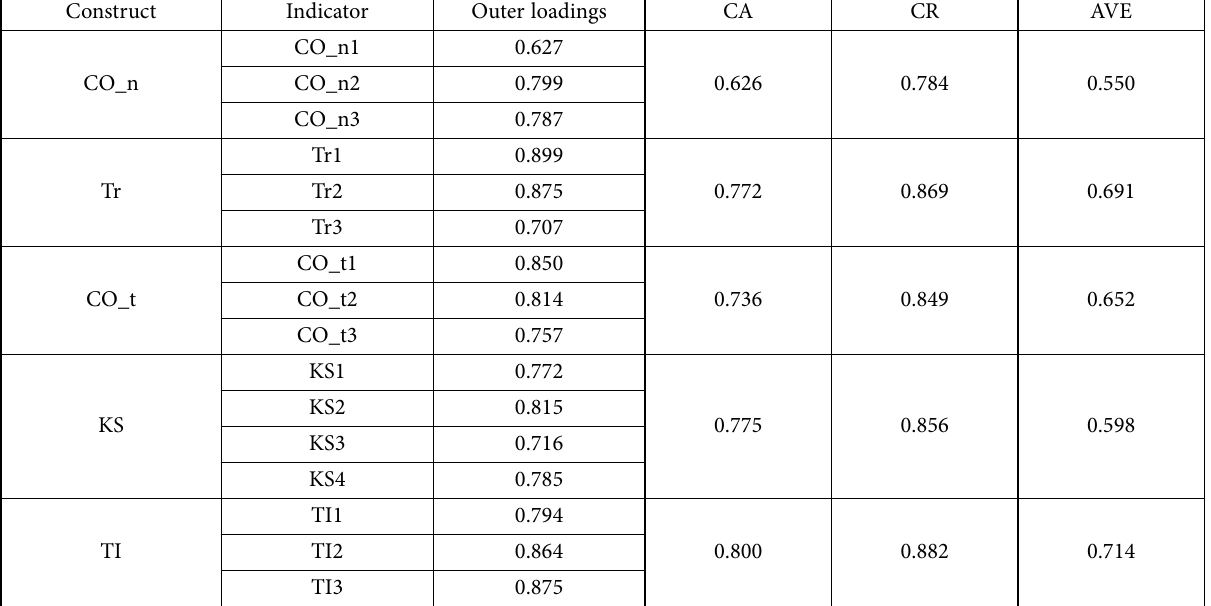
Table 4. Reliability and convergent validity